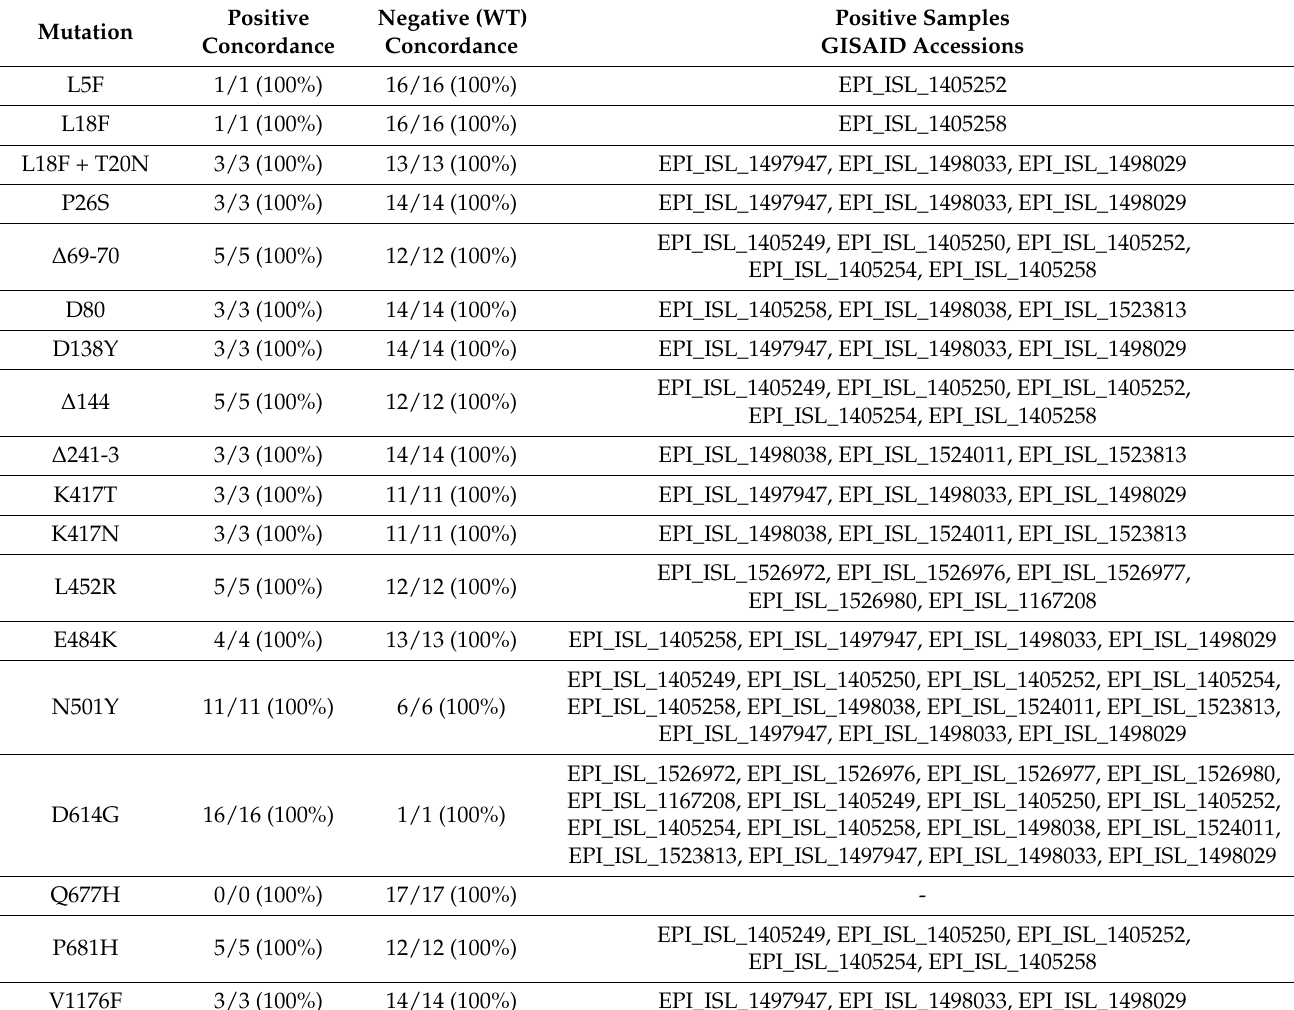
Figure 3. Snapback HRM clearly distinguishes SARS-CoV-2 deletional mutations. ( A ) High-resolution melting plots for the spike_del69–70 assay with WT aa69–70 in red and del69–70 in black. ( B ) High-resolution melting plots for the spike_del144 assay with WT aa144 in red and del144 in black. ( C ) High-resolution melting plots for the spike_del241–3 assay with WT aa241-3 in black, del241–3 in red, and the T22282C SNV in blue. Table 3. Assay Validation Results.